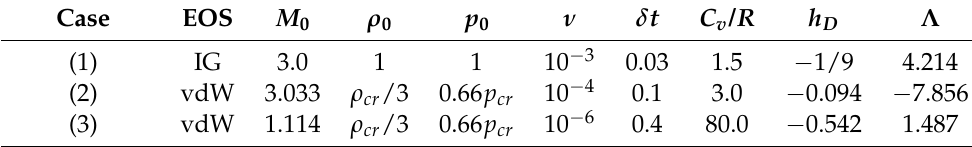
Table 1. Parameters for different cases of the simulation of the shock-stability.